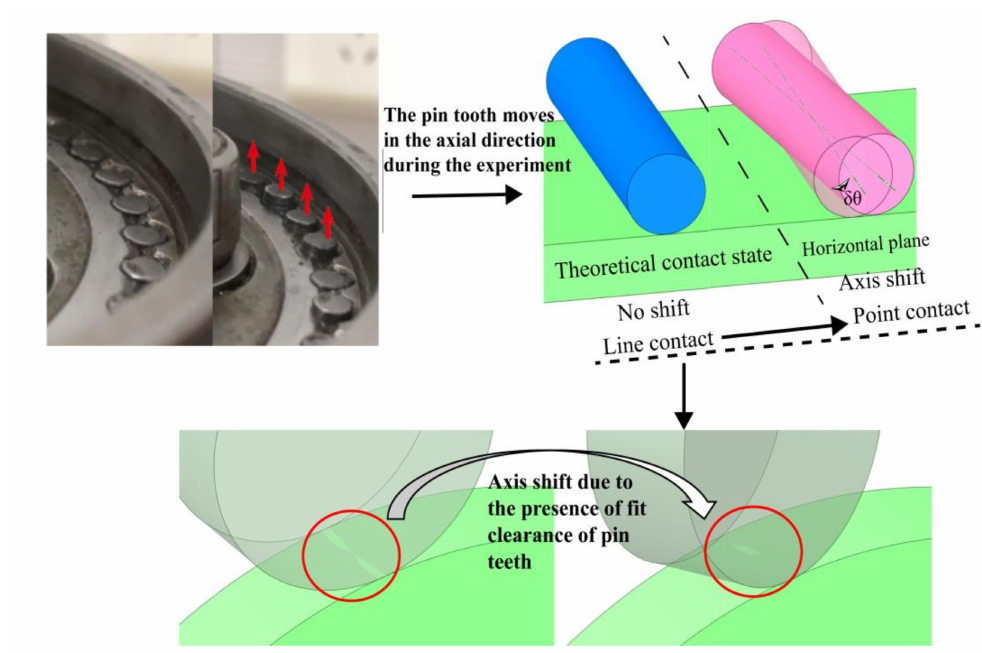
Figure 7. Point contact model of cycloid wheel and pin